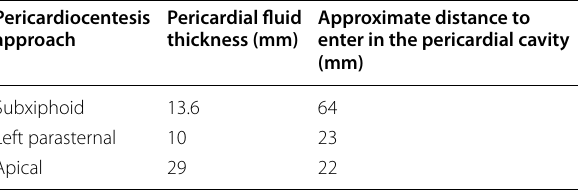
Table 1 Pericardial fluid thickness and distance to reach the pericardial cavity for the three pericardiocentesis approaches of the